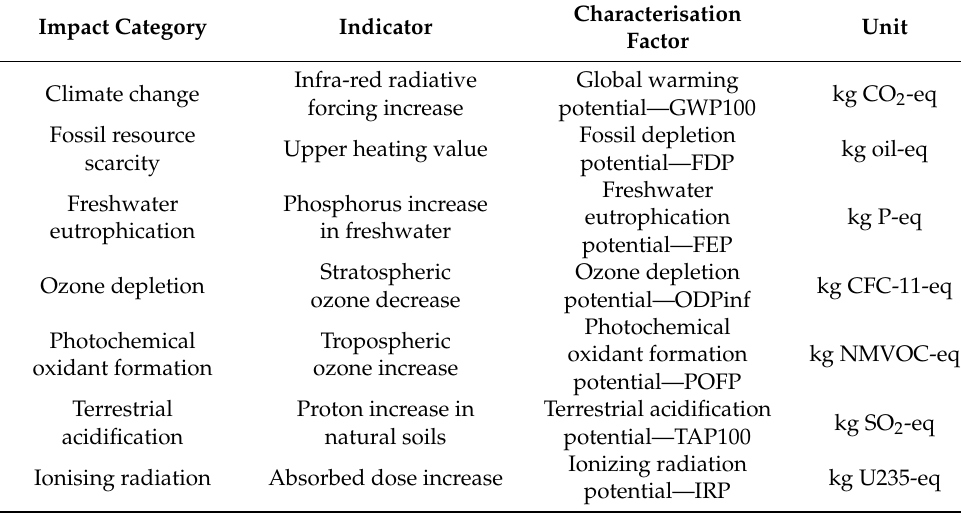
Infra-red radiative forcing increase Upper heating value Phosphorus increase in freshwater Stratospheric ozone decrease Tropospheric ozone increase Proton increase in natural soils